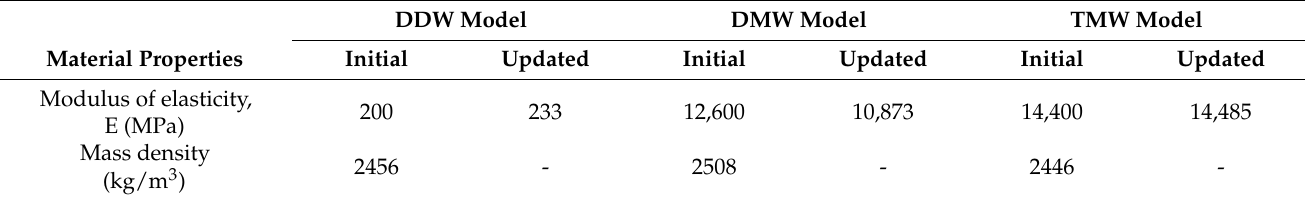
Table 1. Elastic material properties of initial FE models and the results of model updating.